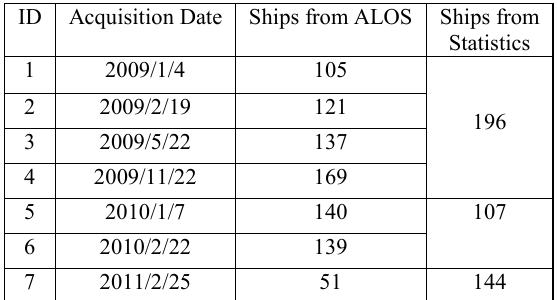
Figure 6. ALOS imagery capturing ship breaking process every 46 days at 1:5,000 scale ©PASCO / Included Material ©JAXA